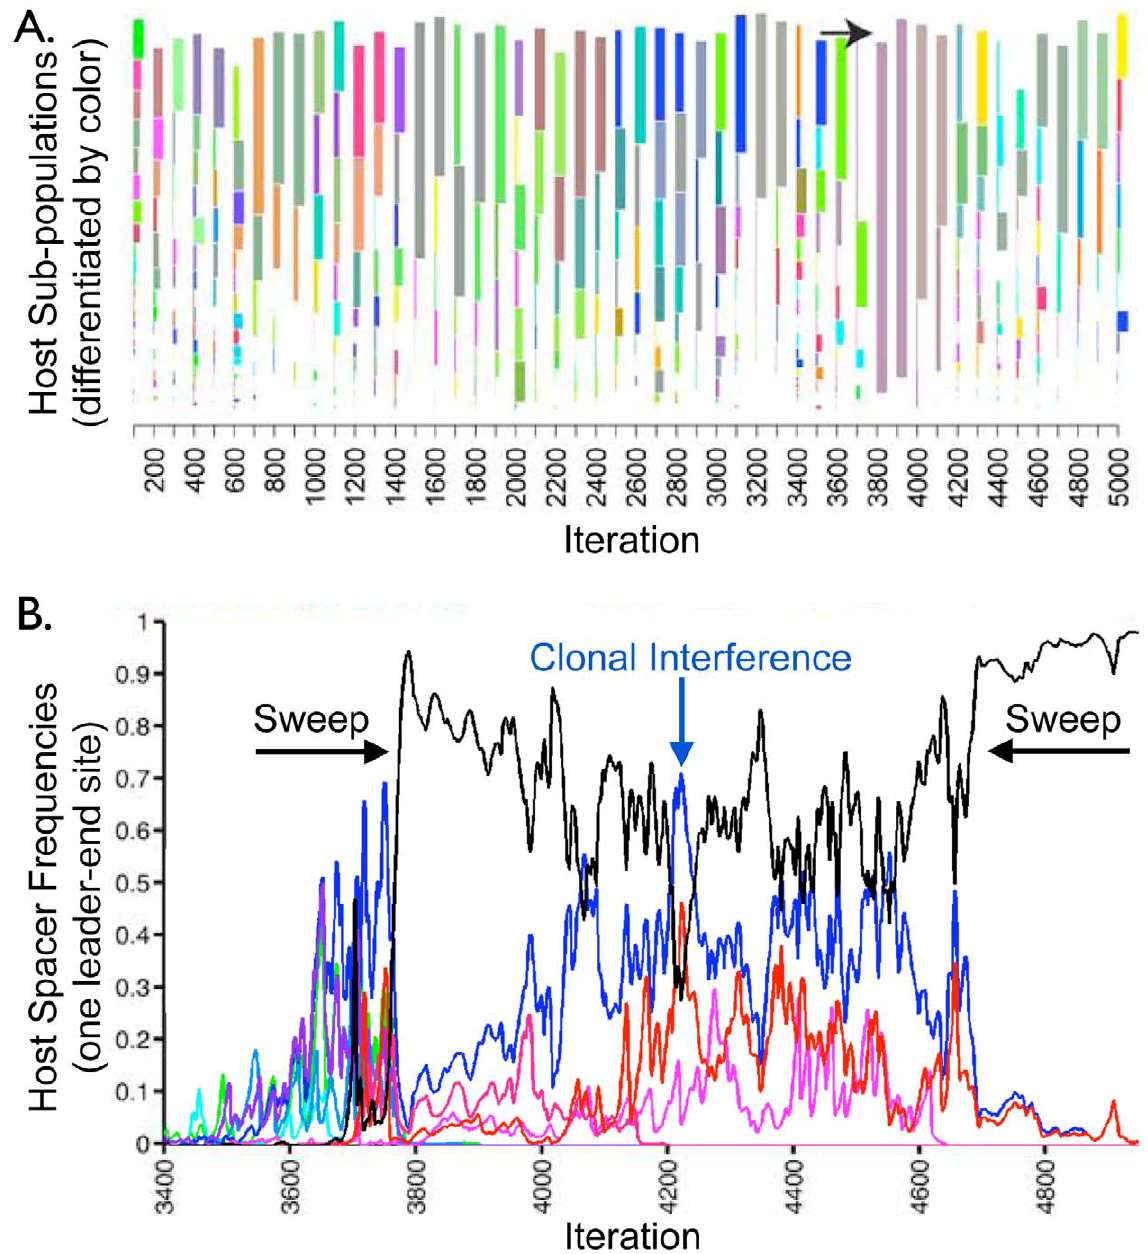
Figure 4. A selective sweep of spacer diversity. (A) Hosts CRISPR loci from the simulation in Figure 3 are clustered (Text S3) into distinct sub- populations every 100 model iterations to capture how trailer-end clonality emerges. Cluster heights represent the cumulative frequencies of all strains in a given cluster, cluster widths show the number of distinct strains in that cluster, and the combined height of all clusters in an iteration reflects the fraction of virus-host interactions that is immune (i.e., host mean fitness). A marked loss of host diversity occurs prior to iteration 3800 ( R ), after which the sweeping sub-population diversifies through distinct leader-end spacer incorporations (Figure S6). (B) The frequencies of all host spacers at a single leader-end column are tracked during the clustering-predicted sweep. A single spacer (shown in black) rapidly rises in frequency before iteration 3800 as predicted by the clustering. Subsequent ‘kill the winner’ oscillations occur before all competing hosts go extinct. A second sweep purges the remaining diversity at this locus